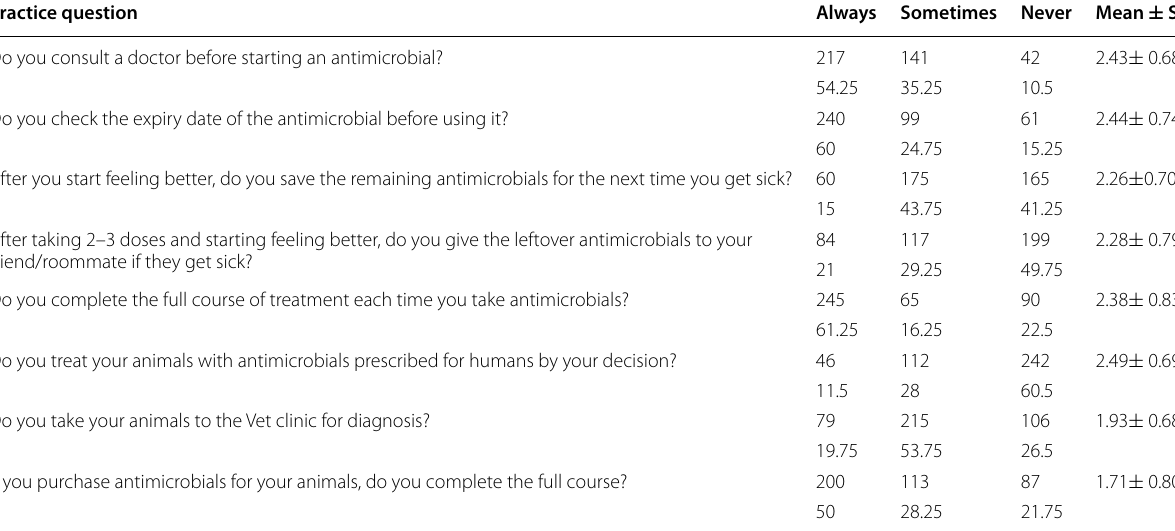
Table 4 Public response to each practice question regarding antimicrobial usage and resistance Practice